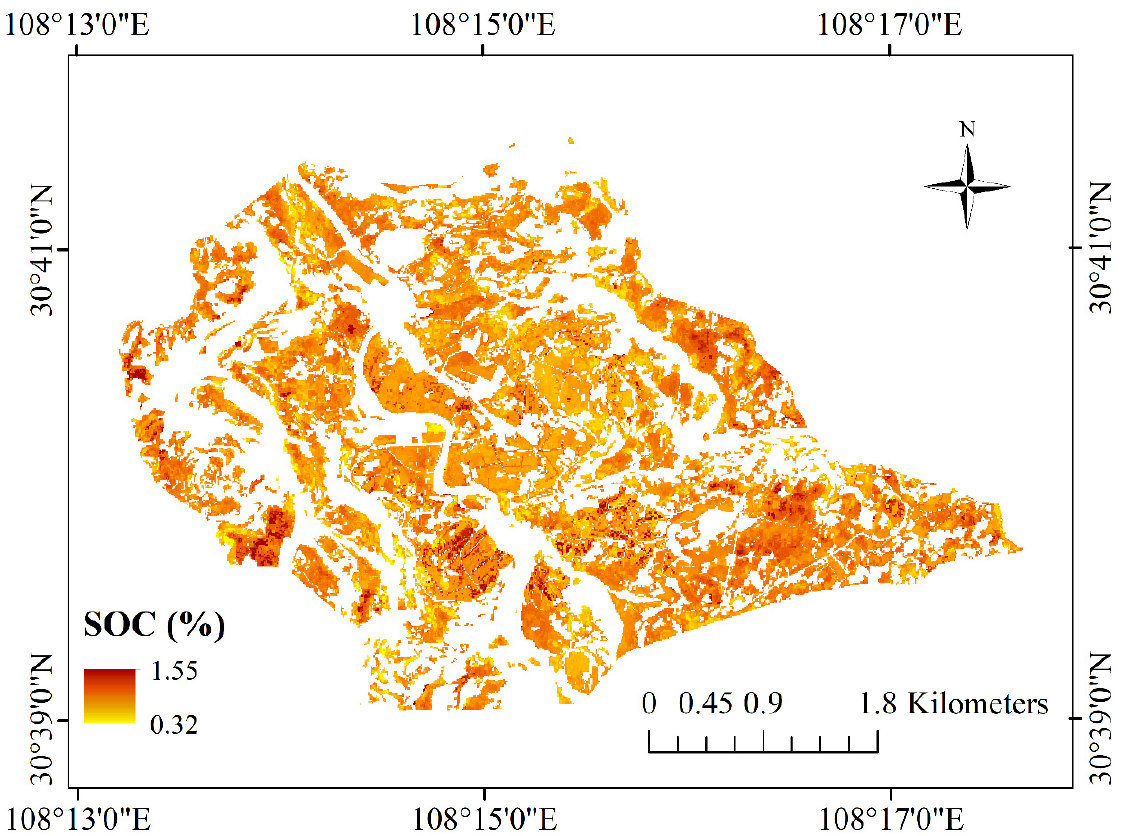
Figure 5. Spatial distribution of SOC content based on Model D with the selected features from DEM, Sentinel-1, and